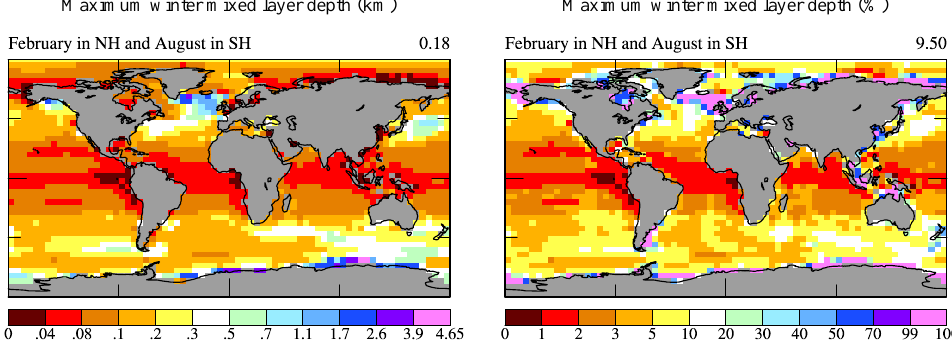
Figure 19. Maximum mixed-layer depth (in km, left, and % of ocean depth, right) in February (Northern Hemisphere) and August (Southern Hemisphere) using the mixed-layer definition of Heuze et al.